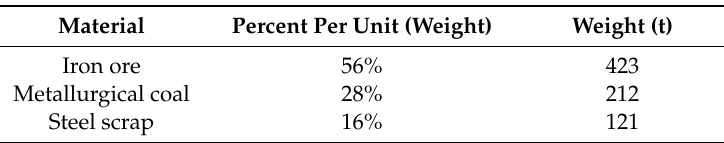
Table 1. Table 1. Steel-BOM.